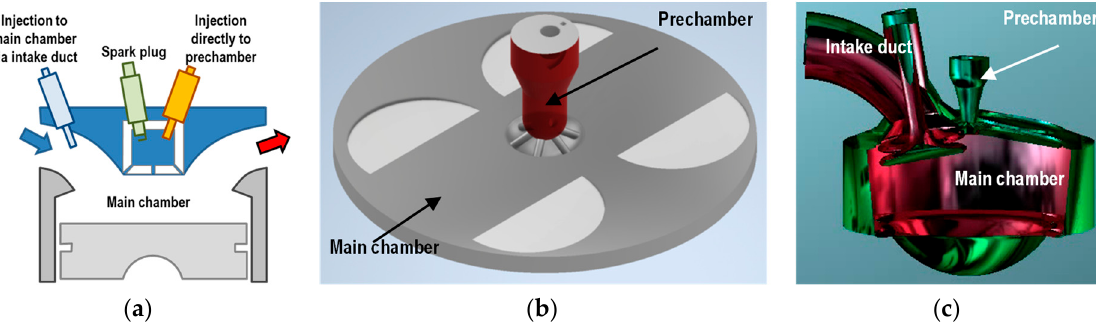
Figure 1. Scheme of cylinder head: ( a ) model of active prechamber; ( b ) view of main and prechamber; ( c ) view of intake duct and combustion chamber (main and prechamber). Table 1. Technical data of the single-cylinder test engine used.